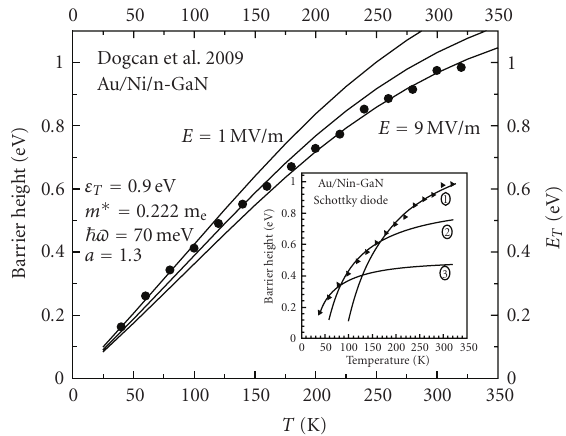
Figure 6: Temperature dependence of the barrier height for Au/Ni/n-GaN from [16] (symbols), fitted to the theoretical E T versus T (solid lines) computed for field strengths of 1, 5, 9 (MV/m). Note that theoretical E T is higher at lower fields. The inset shows barrier height versus T from the same work. The continuous curves in the inset correspond to Φ b computed by authors of [16] using TE model for the three Gaussian distributions of the barrier height.